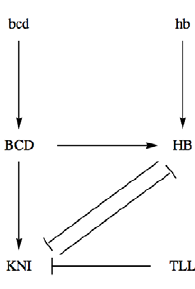
Figure 1. Graph describing the genetic network associated with the production of proteins Bicoid (BCD), Hunchback (HB), Knirps (KNI) and Tailless (TLL) in Drosophila early development. mRNAs hunchback and bicoid are represented by hb and bcd respectively. Arrows represent activations and are listed in the set of ordered pairs E a . Lines with perpendicular endings represent repres- sions and are listed in the set E r .